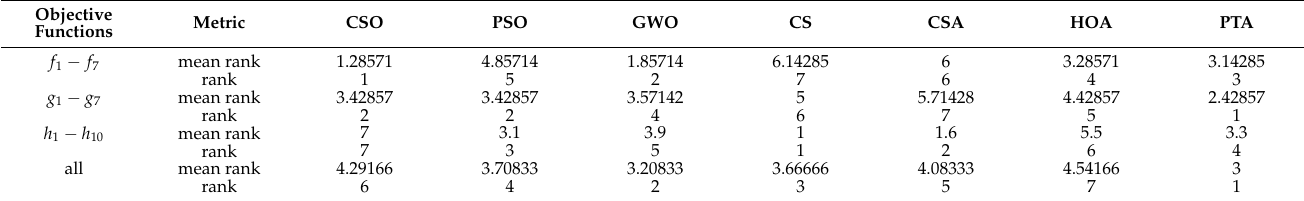
Table 7. Rank Comparison Results